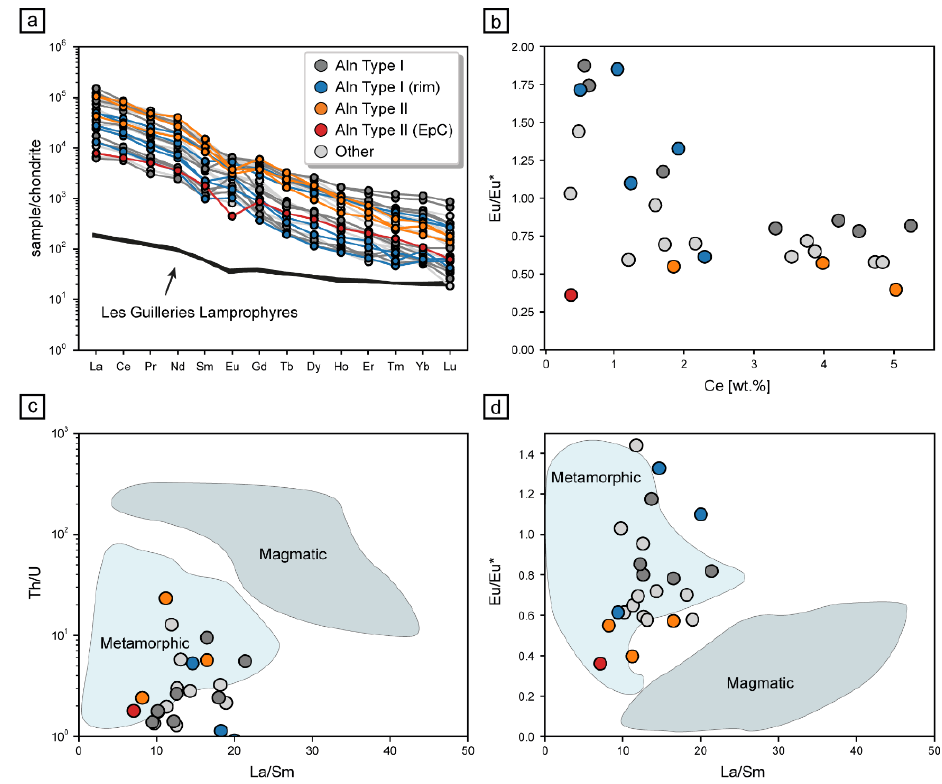
Figure 7. Trace elements of allanite from Les Guilleries lamprophyre dykes obtained by LA-ICP-MS. ( a ) Chondrite-normalized REE patterns of defined allanite types. Normalizing values are from Sun and McDonough [51]. ( b ) Ce vs. Eu/Eu* [Eu/Eu* = (Eu)cn/[(Sm)cn × (Gd)cn]0.5]. ( c ) Th/U vs. La/Sm. ( d ) Eu/Eu* vs. La/Sm. Magmatic and metamorphic allanite fields from [25,26].